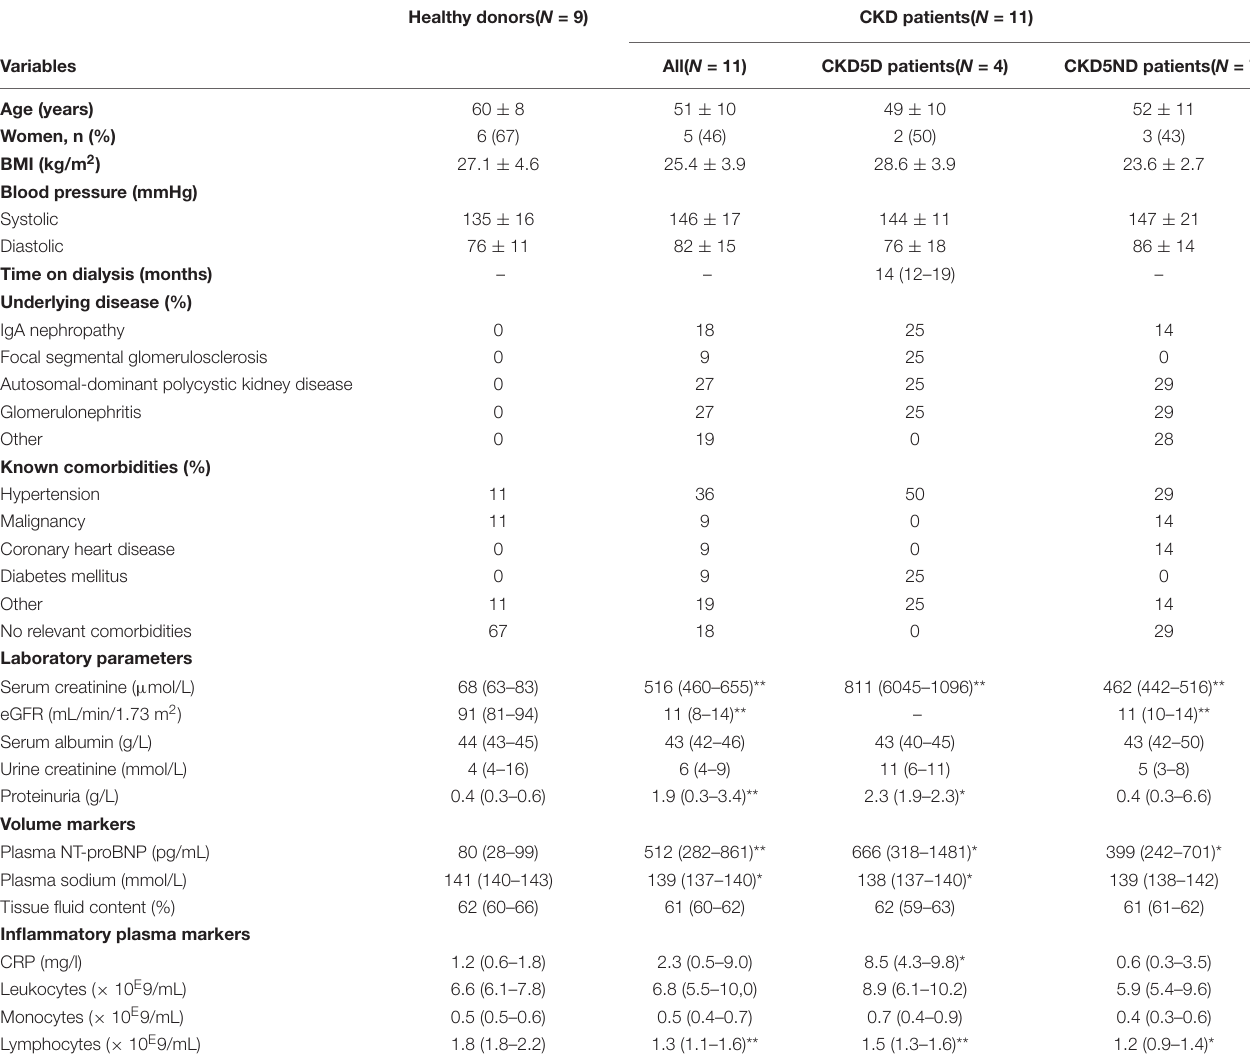
TABLE 1 | Baseline characteristics of donors and all CKD patients (CKD5D and CKD5ND) just before surgery. Healthy donors( N =